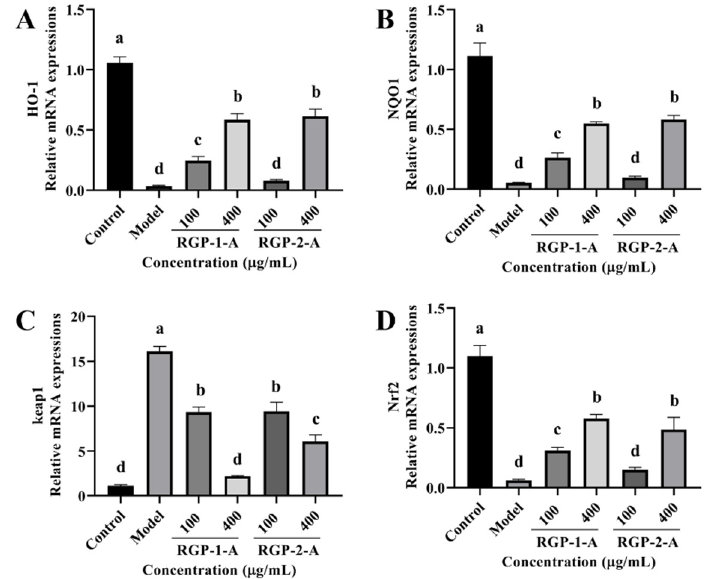
Figure 9. Effect of RGP pretreatment on the antioxidant enzyme content and relative mRNA expres- sion of antioxidant pathway-related proteins in LPS-induced IPEC-J2 cells. ( A ), HO-1; ( B ), NQO1; ( C ), Keap1; ( D ), Nrf2 mRNA relative expression. RGP-1-A: decolorized pure polysaccharides of RGP obtained using AB-8 macroporous resin; RGP-2-A: decolorized pure polysaccharides of RGP obtained using H 2 O 2 . On the bar graphs, different lowercase letters signify a significant difference ( p < 0.05).